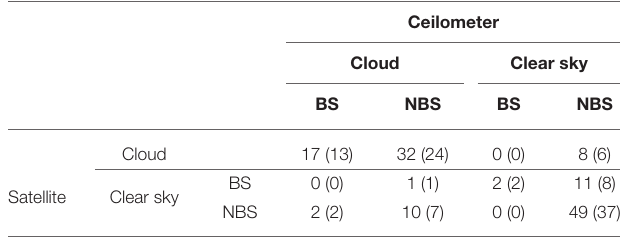
TABLE 5 | Overview of the comparison between ceilometer and satellite detections at the Princess Elisabeth station, number of observations (% relative to the total number, 132).